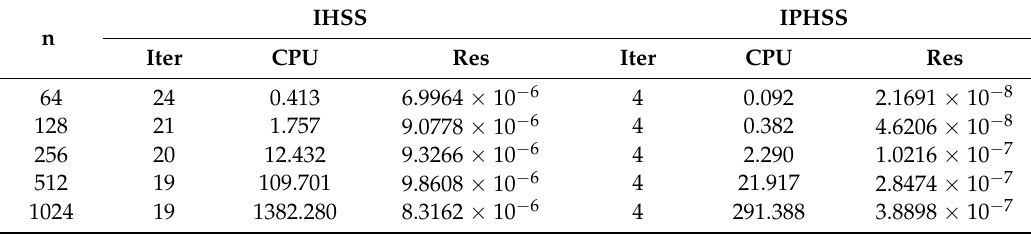
Table 2. Comparison of calculation results between IHSS and IPHSS